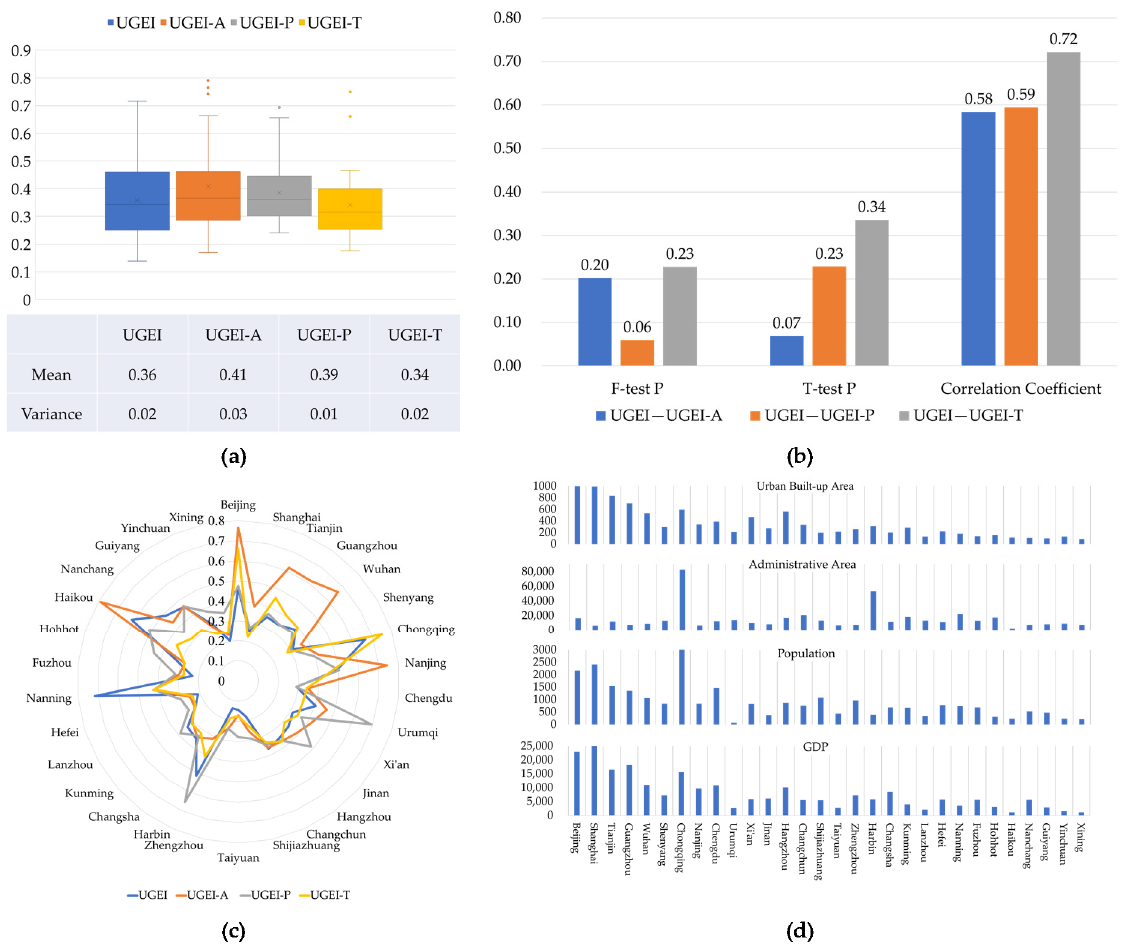
Figure 13. Comparison of UGEI, UGEI-A, UGEI-P, and UGEI-T results: ( a ) Comparison of statistical indicators, ( b ) F-test, T-test and correlation coefficients, ( c ) Provincial city indicator results, ( d ) Urban area, administrative area, population and GDP of each city.